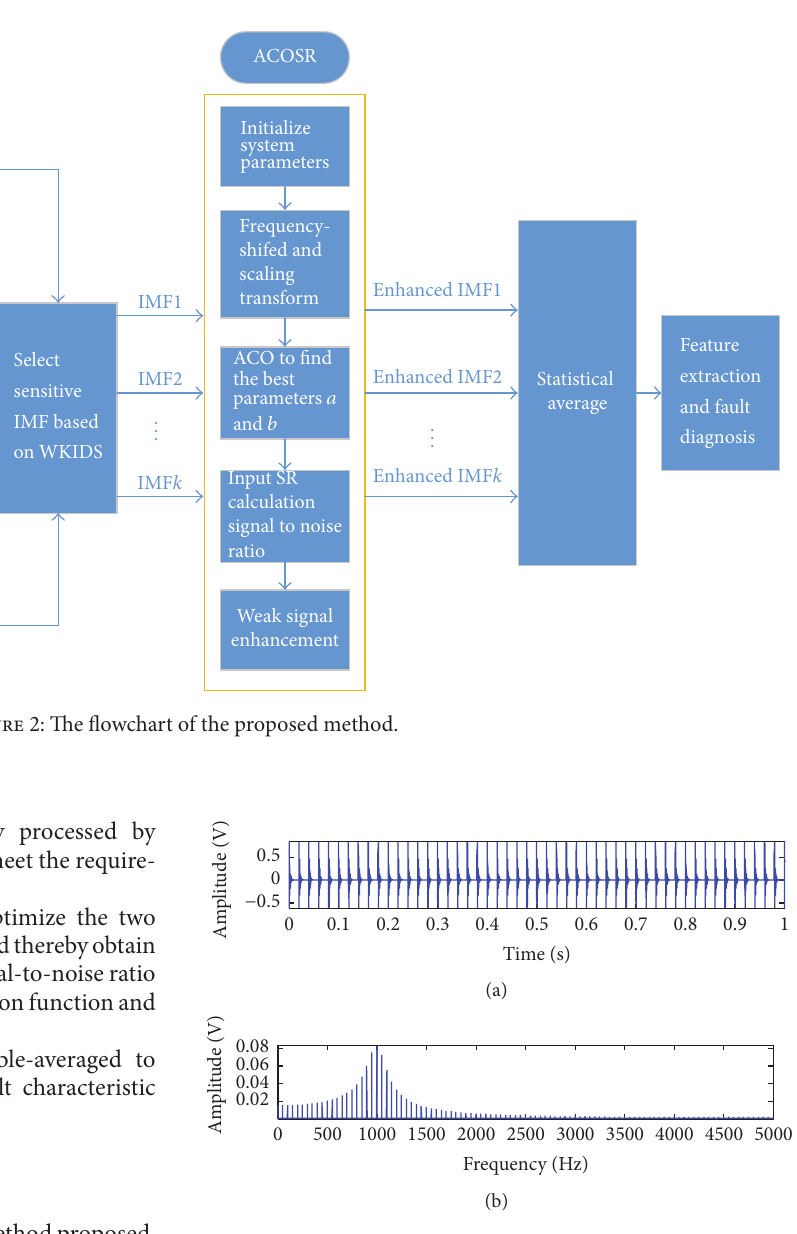
Figure 3: The periodic pulse signal: (a) time-domain waveform; (b) frequency